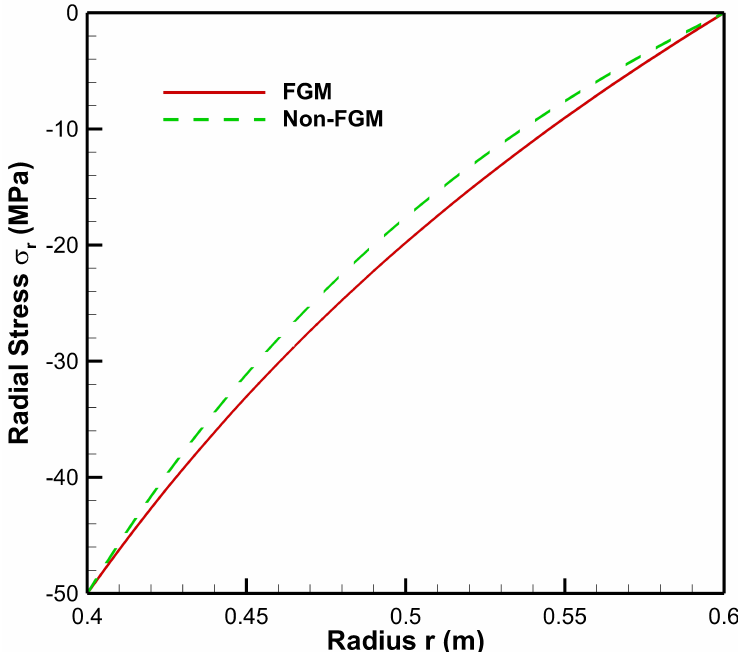
Figure 4. Radial Stress along the radius of the cylinder under internal pressure, P a = 50 MPa.